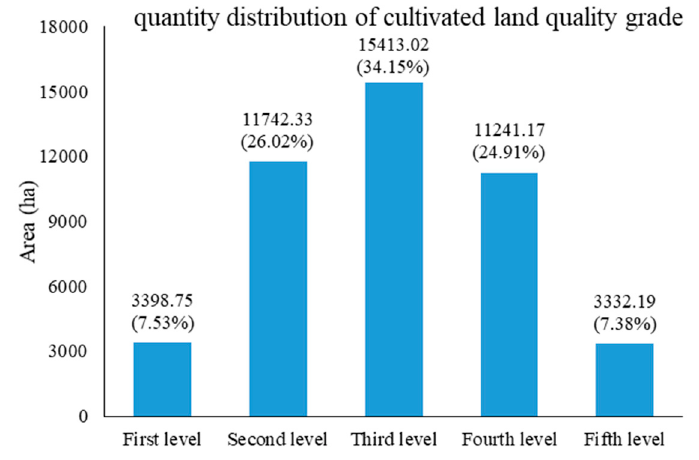
Figure 2. Quantity distribution of cultivated land quality grade in the study area.